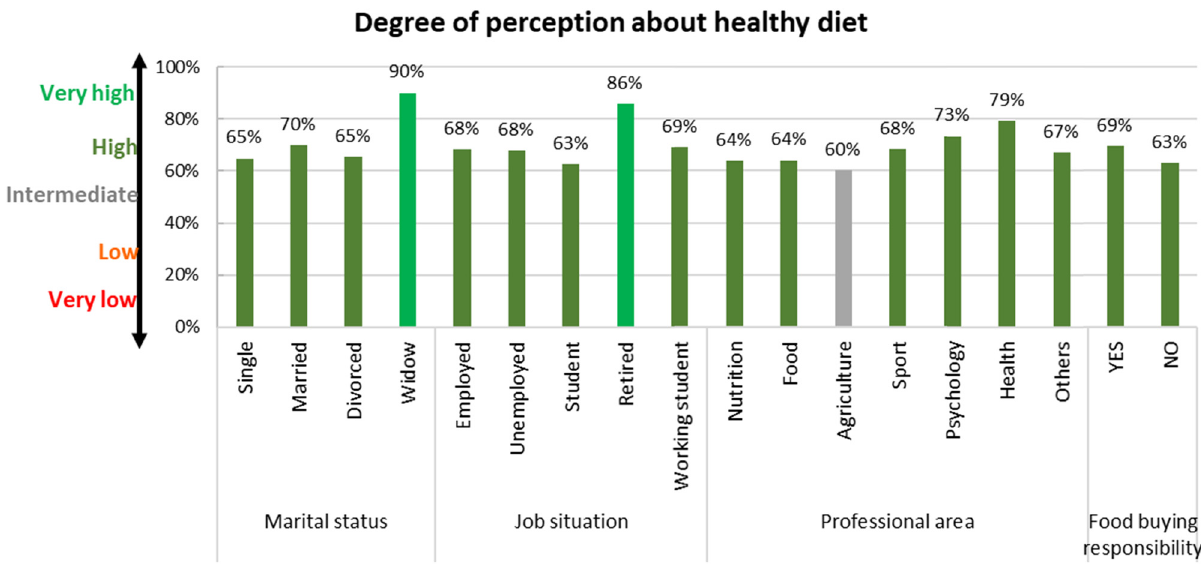
Figure 1: Degree of perception about a healthy diet according to some sociodemographic